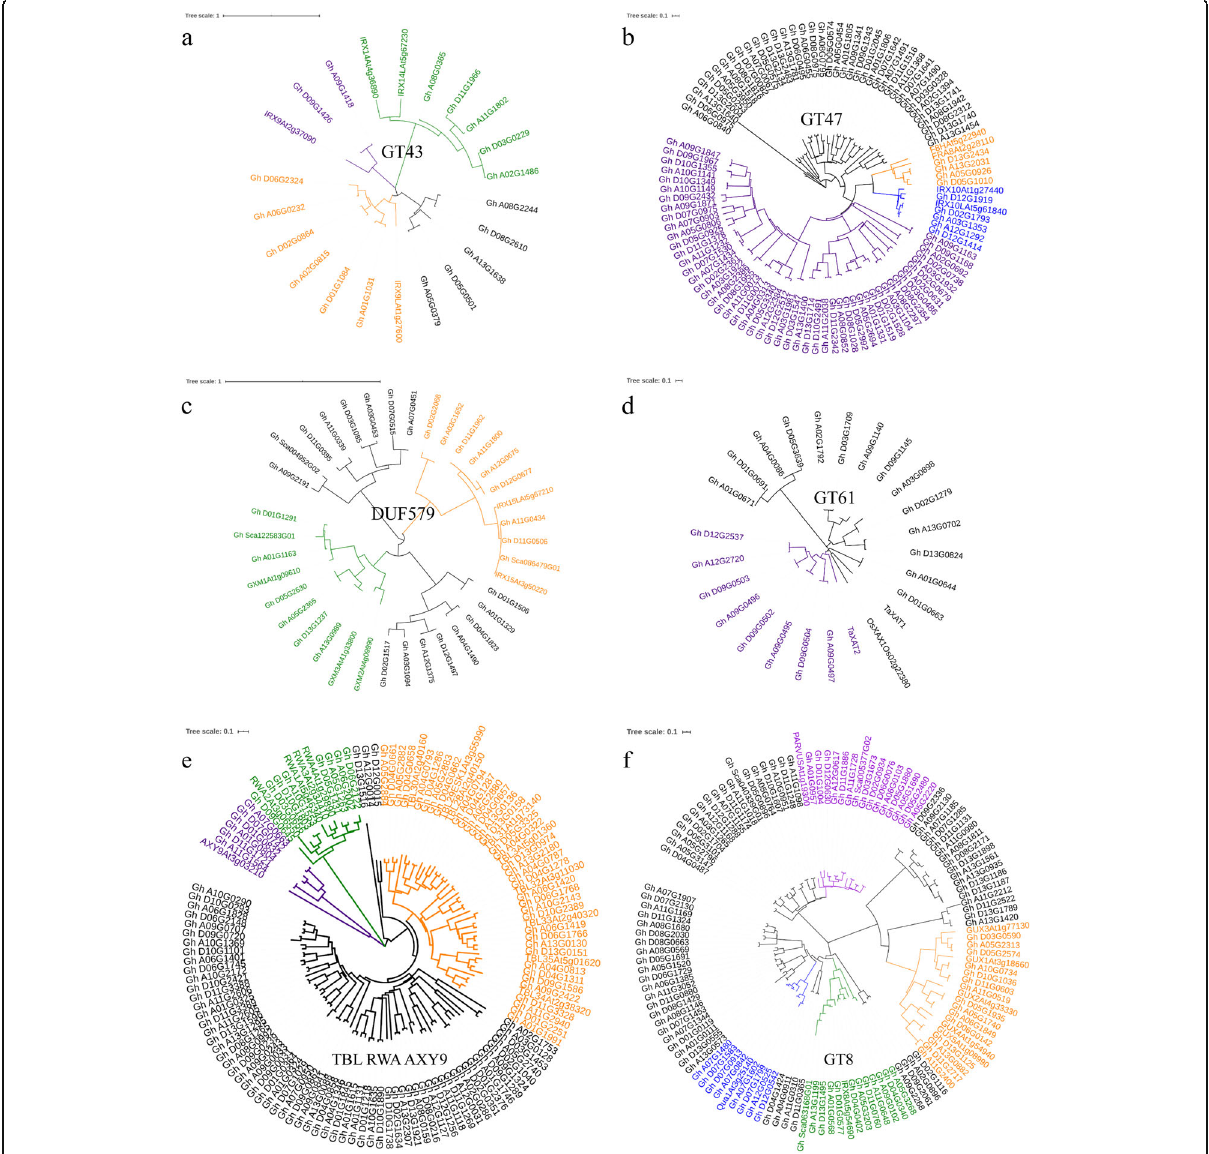
Fig. 1 Phylogenetic analysis of putative cotton fiber xylan synthesis-associated proteins and 35 Arabidopsis homologs. a Phylogenetic tree of Arabidopsis and cotton GT43 family members. Several xylan-associated Arabidopsis GT43 members and their cotton homologs are highlighted in different color. b Phylogenetic tree of Arabidopsis and cotton GT47 family members. Several xylan-associated Arabidopsis GT47 members and their cotton homologs are highlighted in different color. c Phylogenetic tree of Arabidopsis and cotton DUF579-domain containing proteins. Several xylan-associated Arabidopsis DUF579-domain containing proteins and their cotton homologs are highlighted in different color. d Phylogenetic tree of Arabidopsis and cotton GT61 family members. e Phylogenetic tree of Arabidopsis and cotton TBL, RWA and AXY9 family members. The cotton TBL family comprises 100 genes in three subclades, with 9 additional genes homologous to reduced wall O-acetylation (RWA) and 6 related to Arabidopsis xyloglucan acetyl transferase9 (AXY9). f Phylogenetic tree of Arabidopsis and cotton GT8 family members. Several xylan-associated Arabidopsis GT8 members and their cotton homologs are highlighted in different (Fig. 3a, Additional file 9: Table S1). Thus, they repre- sent strong candidates for fiber xylan biosynthesis.